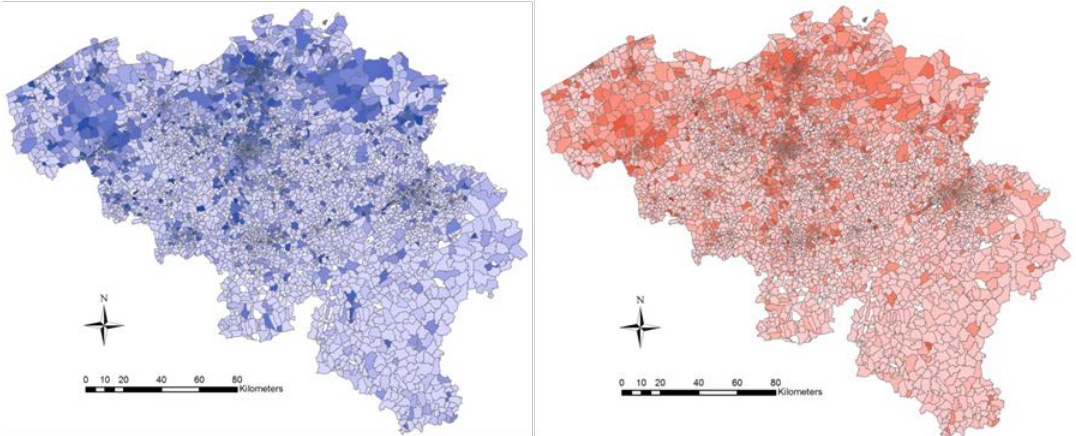
Figure 5. Generated (left) and attracted (right) volumes (in tonnes) for all commodity types and loading units on TAZ